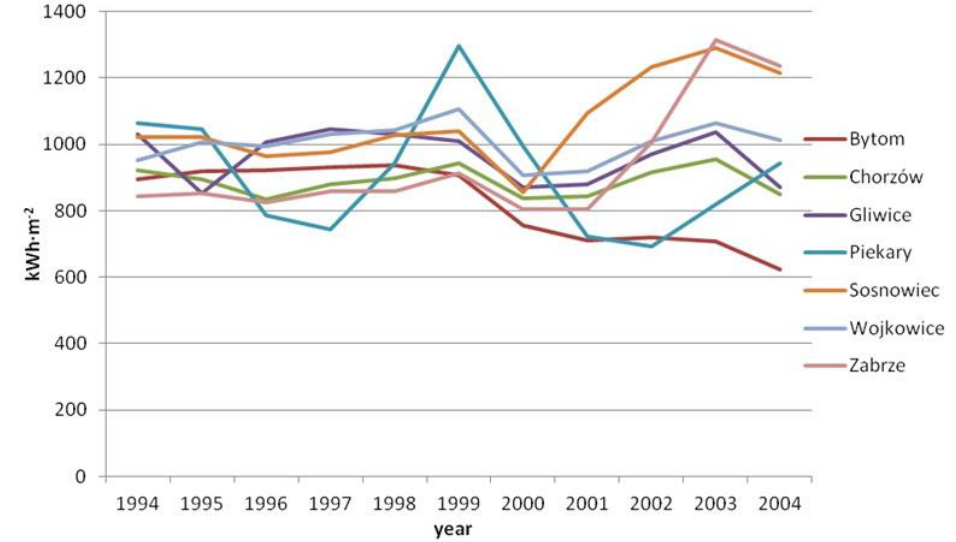
Fig. 2. Range of global solar radiation at selected stations in 1994–2004 [kWh·m -2